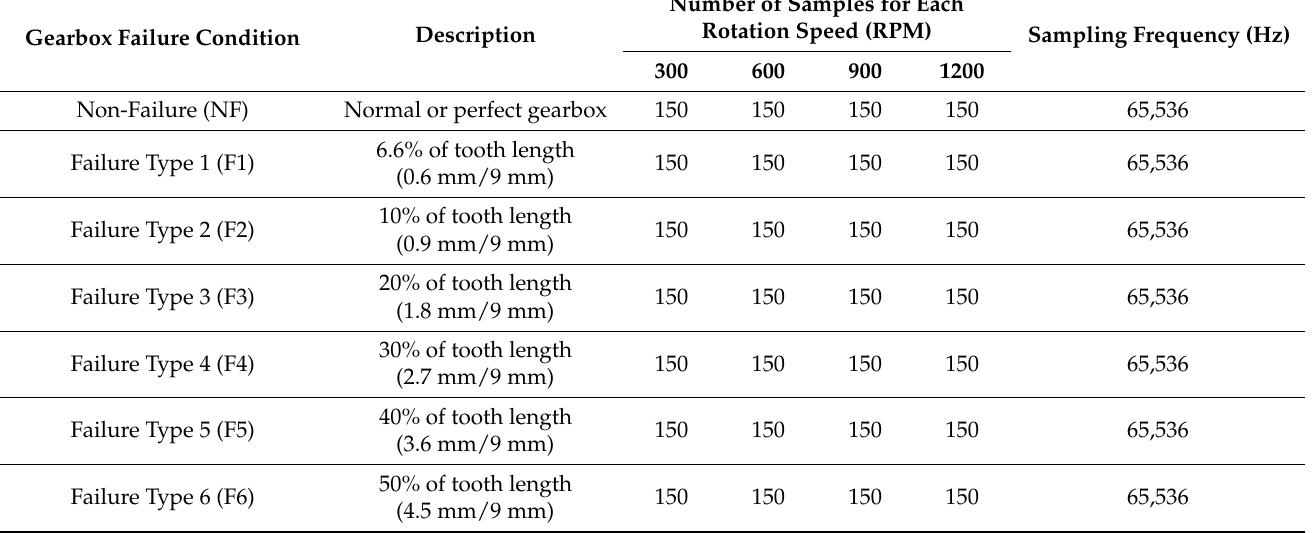
Table 2. The vibration dataset for the MTCF gearbox obtained from the test rig and data acquisition